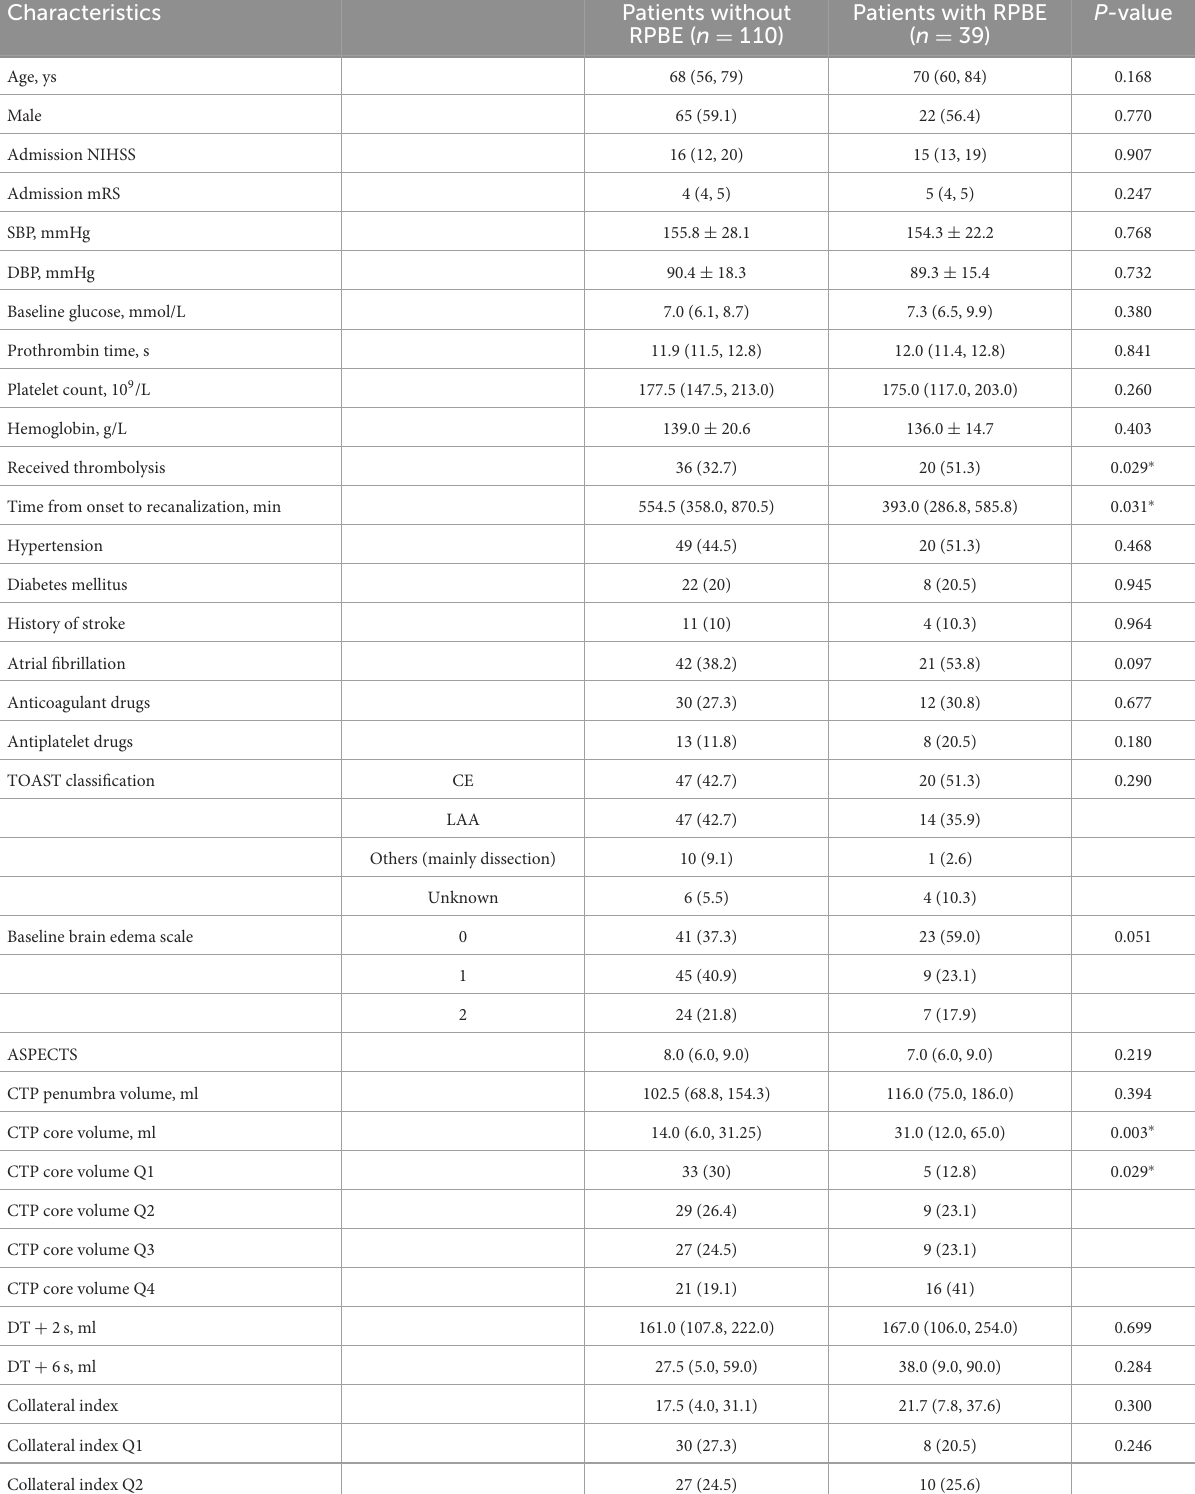
TABLE 1 Baseline characteristics of the study population compared between participants with and without RPBE.